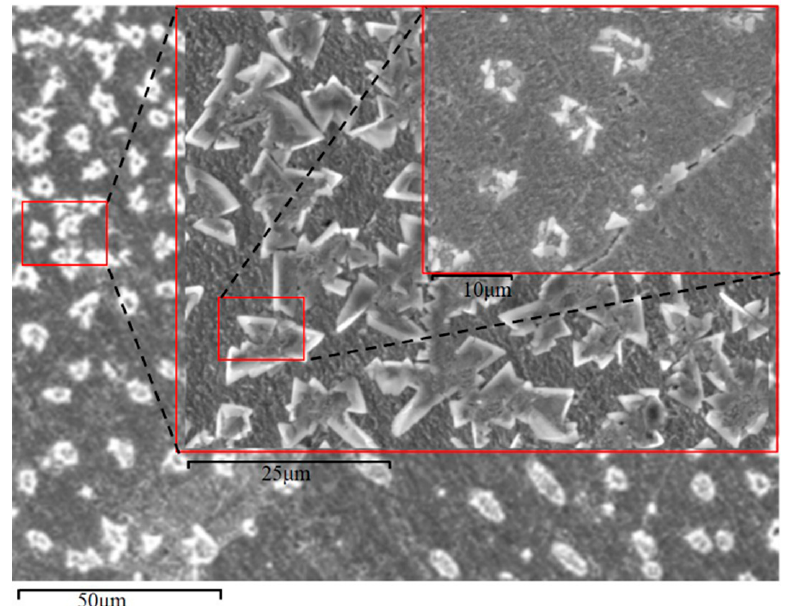
Figure 5. SEM morphology of microwave-sintered Cu-rGO composites.